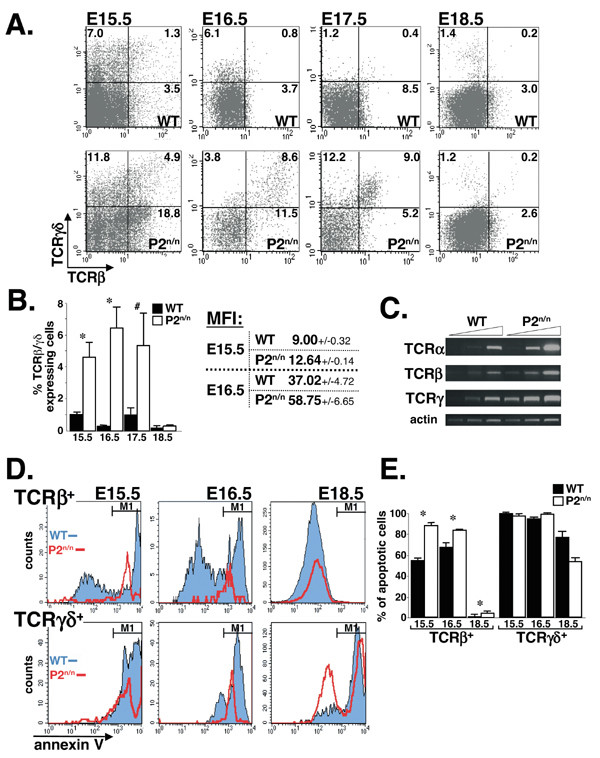
The propensity of P2neo/neo thymocytes to undergo apoptosis is associated with elevated expression of TCRβ and TCRγδ. (A and B) Expression of TCRβ and TCRγδ on WT and P2neo/neo embryonal thymocytes. (A) Shown are FACS analysis dot plots of E15.5 to E18.5 WT and P2neo/neo thymocytes indicating the percentages of cells in each quadrant. Histograms in (B) show the average ± S.E. of TCRβ/TCRγδ proportions of WT and P2neo/neo thymocytes in at least three experiments at each developmental stage. The difference between WT and P2neo/neo was significant at P < 0.005 (*) and P < 0.05 (#) by Student's t test. While at E15.5 to E17.5 the proportion of TCRβ/TCRγδ expressing thymocytes was much higher in P2neo/neo compared to WT, at E18.5 the distribution of P2neo/neo thymocytes resumed normal pattern. The mean fluorescence intensity (MFI) (B right) of E15.5 and E16.5 TCRβ+ P2neo/neo thymocytes was significantly higher than WT (p < 0.005; by Student's t test). (C) Expression of TCRβ/TCRγδ in P2neo/neo thymocytes is transcriptionally upregulated. RT-PCR analysis of RNA derived from WT and P2neo/neo E16.5 thymocytes using primers specific for the pre-TCRα and the constant regions of TCRβ and TCRγ transcripts. Increased number of PCR cycles shows elevated steady-state levels of mRNAs in P2neo/neo thymocytes compared to WT. (D and E) Enhanced apoptosis of P2neo/neo thymocytes is associated with elevated expression of TCRβ/TCRγδ. (D) Histograms demonstrating the proportion of apoptotic cells among TCRβ+ or TCRgδ+ thymocytes. TCRβ/TCRγδ positive WT thymocytes (blue) are divided into two main populations, apoptotic (M1) and non-apoptotic, according to level of Annexin V (except for E15.5 TCRγδ+ where all cells are apoptotic). Most of TCRβ/TCRγδ positive P2neo/neo thymocytes (red), are at the M1 (Annexin Vhigh) apoptotic subset. (E) Proportion of apoptotic thymocytes among TCRβ/TCRγδ positive E15.5, E16.5 and E18.5 thymocytes. Bars represent the average ± S.E. of at least three independent experiments for each time point using different mice. The differences between WT and P2neo/neo in number of TCRβ+ apoptotic thymocytes were significant at P < 0.01 (*) by Student's t test.